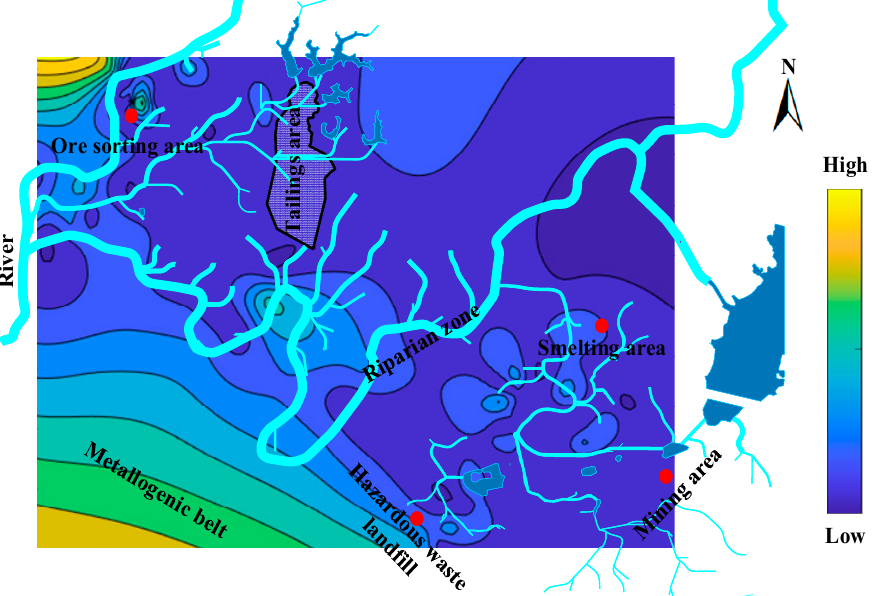
Figure 4. Spatial risk distribution of cadmium pollution in the soil from an abandoned lead/zinc mine.